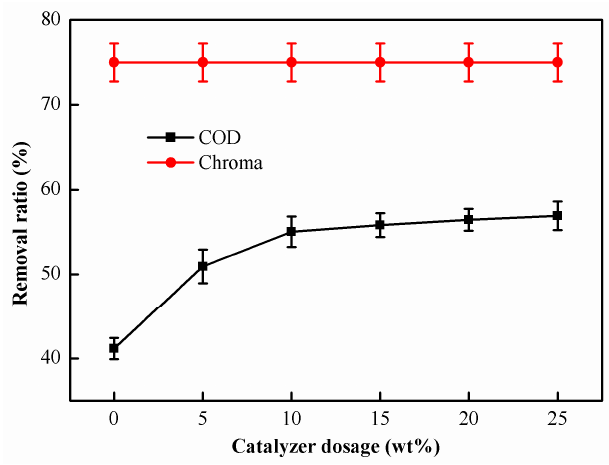
Figure 9. Effect of catalyst dosage on catalytic oxidation performance.